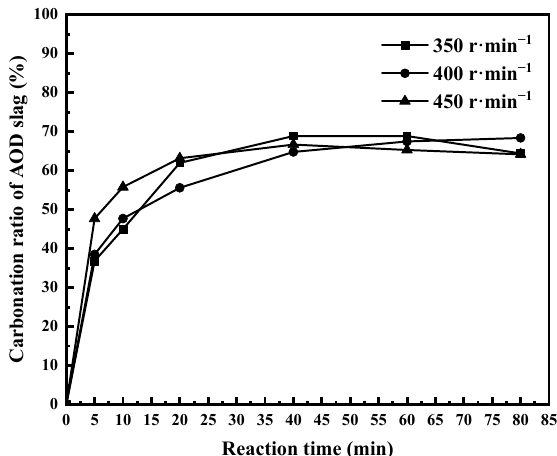
Figure 4. Effect of stirring speed on carbonation of the AOD slag.